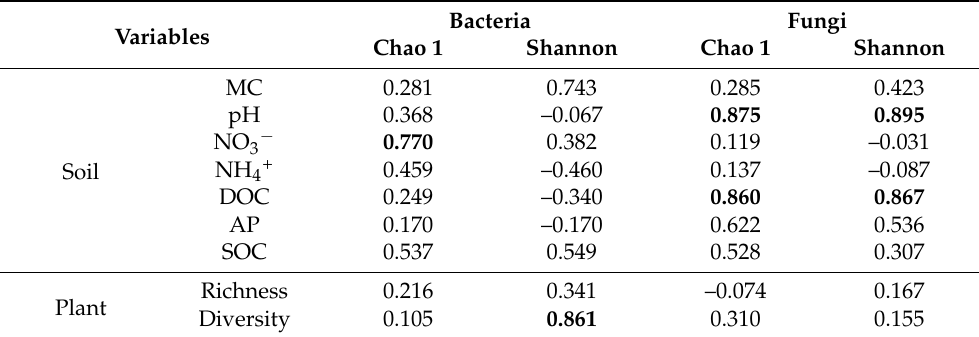
Table 3. Pearson’s correlation between microbial alpha-diversity indices and environmental factors of the study area (n = 24).